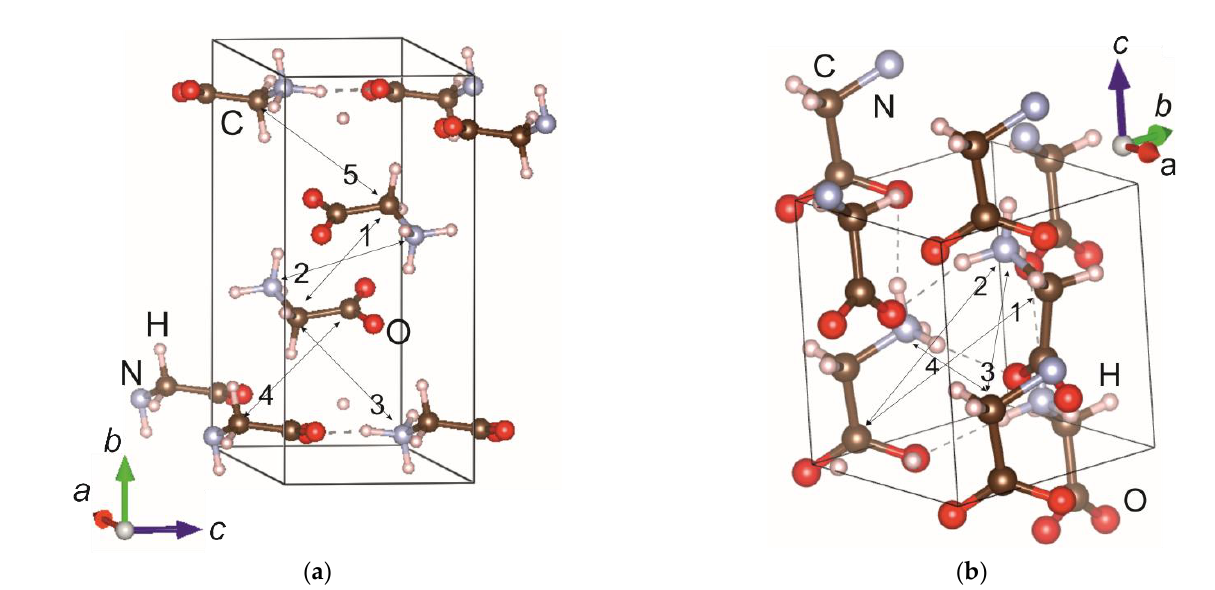
Figure 2. Crystal structures of ( a ) α -Gly:CA (90:10) and (b) γ -Gly:CA (80:20). Selected interatomic distances are marked in ( a ) for α -Gly:CA (90:10) (1: 0.44 nm, 2: 0.53 nm, 3: 0.45 nm, 4: 0.49 nm, 5: 0.50 nm) and in ( b ) for γ -Gly:CA (80:20) (1: 0.60 nm, 2: 0.55 nm; 3: 0.54 nm; 4: 0.69 nm). Maximum size of flat CA molecule is ~0.5 nm. Table 2. Comparison of unit cell parameters a , b , c , angle β , and unit cell volume V cell in α -Gly:CA (90:10) and nominally pure α -Gly crystals from [52,53].